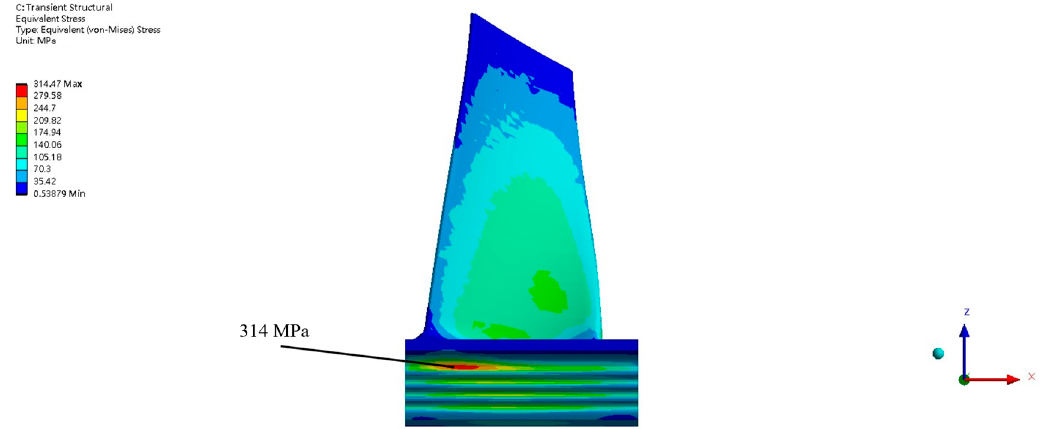
Figure 23. The stress distribution of the 2nd stage blade .